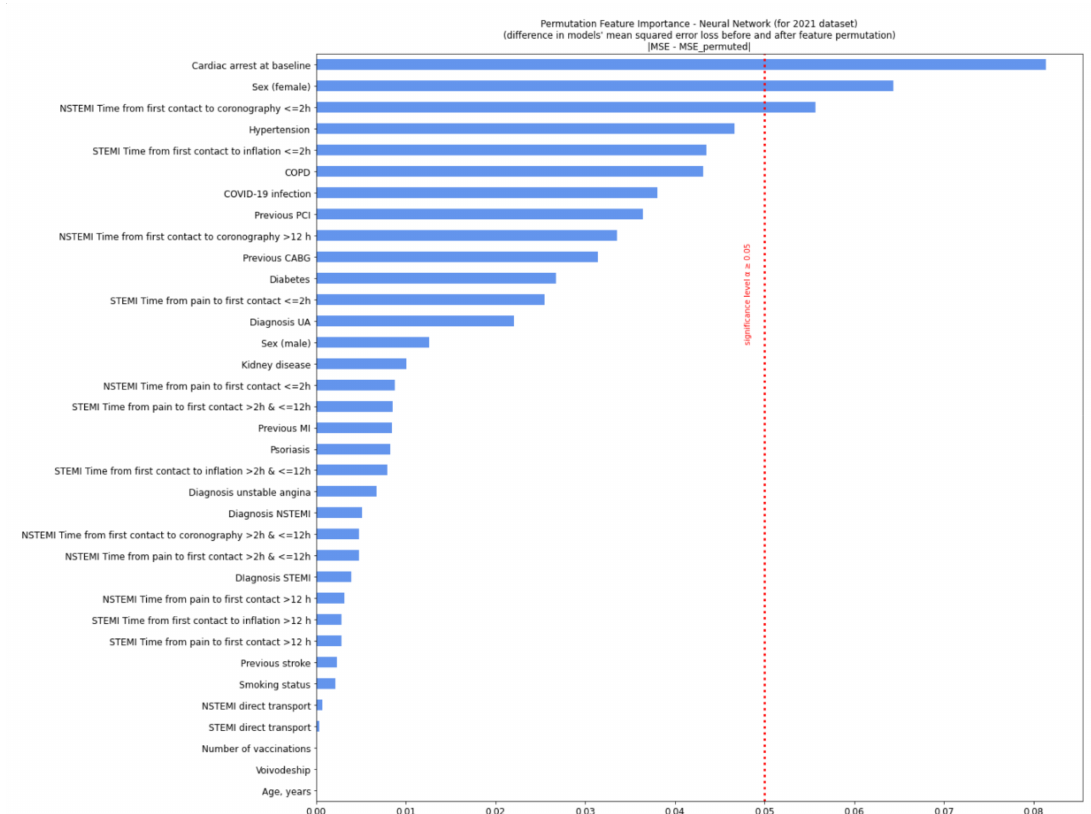
Figure 3. Permutation feature importance analysis for patients in 2020. The diagram shows a decrease in the model’s efficiency when values in single individual features are randomly shuffled column-wise and the rest of the features are left unchanged. We measured neural network efficiency by calculating the mean squared error (MSE) between the target value (true number of deaths during the procedure) and the predicted value (model’s output). The calculation was conducted for each row from data separately and then averaged. In permutation feature importance, the difference between the MSE error from the neural network, predicting the value from the non-preprocessed dataset, and the MSE error from the neural network—predicting the value from the permuted dataset was measured and showed a decrease on the plot. Variables, when permuted, were affected most in the model’s efficiency